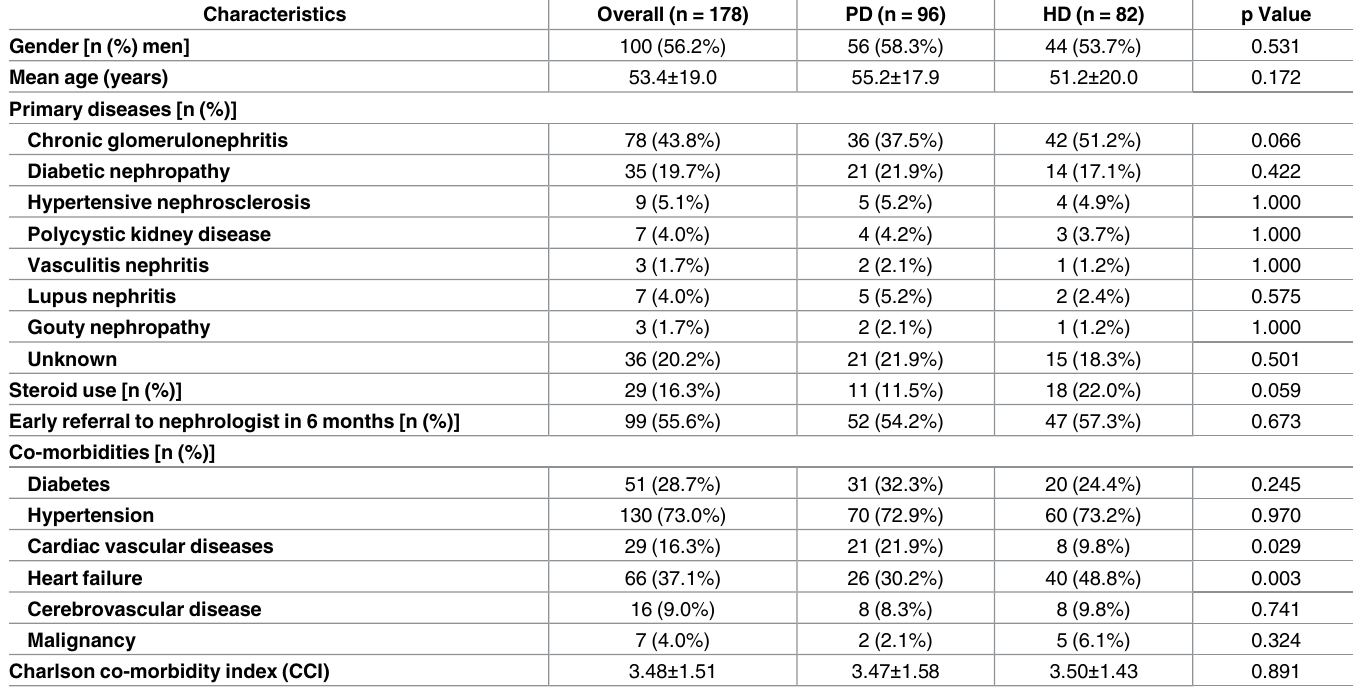
Table 1. Demographic and Baseline Characteristics of the Study Patients.